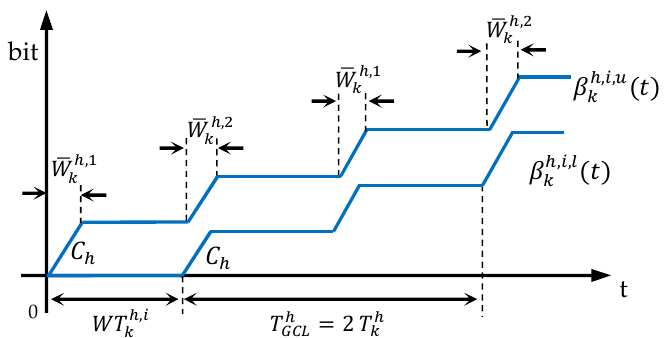
Figure 12. Upper and lower bounds of the service curve based on the waiting time limits.